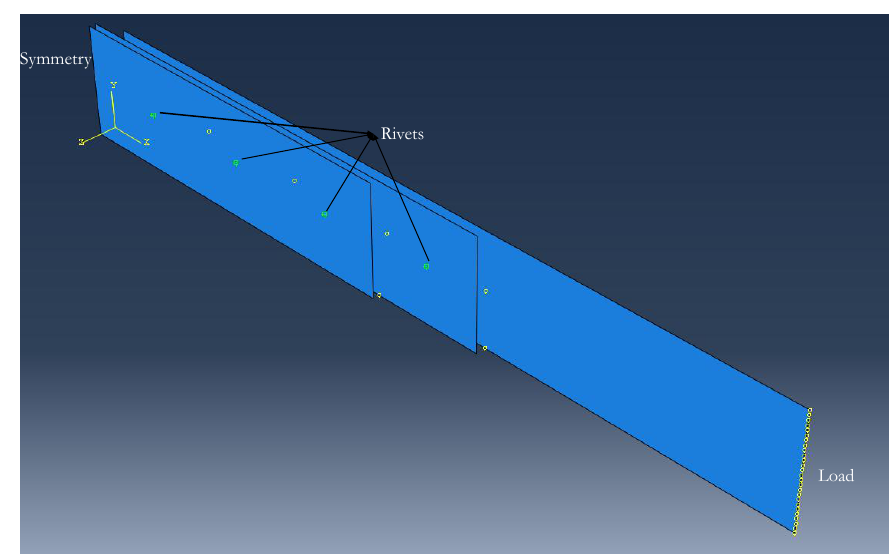
Figure 3. Finite element model in Abaqus CAE of the composite-composite riveted joint with the load and symmetry boundary conditions indicated in their respective edges.